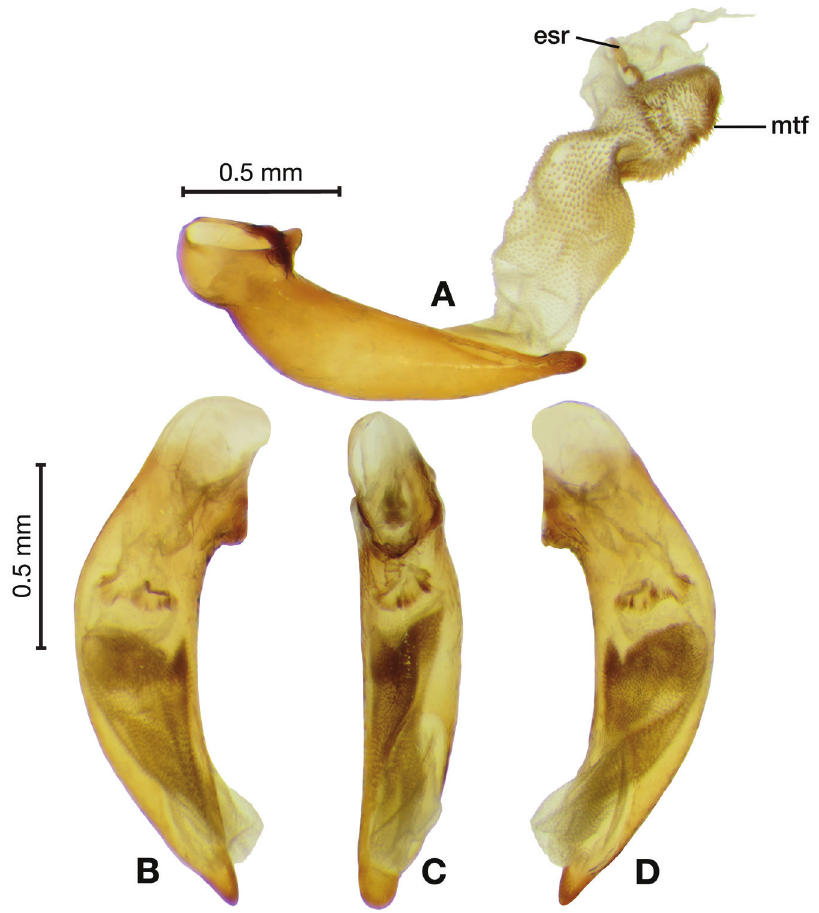
Figure 51. Digital images of male genitalia of C. ( Coptoderina ) occulta sp. n.. A right lateral aspect, endophallus everted B right lateral aspect C ventral aspect D left lateral aspect. Legend: esr endophallus sclerite ring; mtf microtrichial